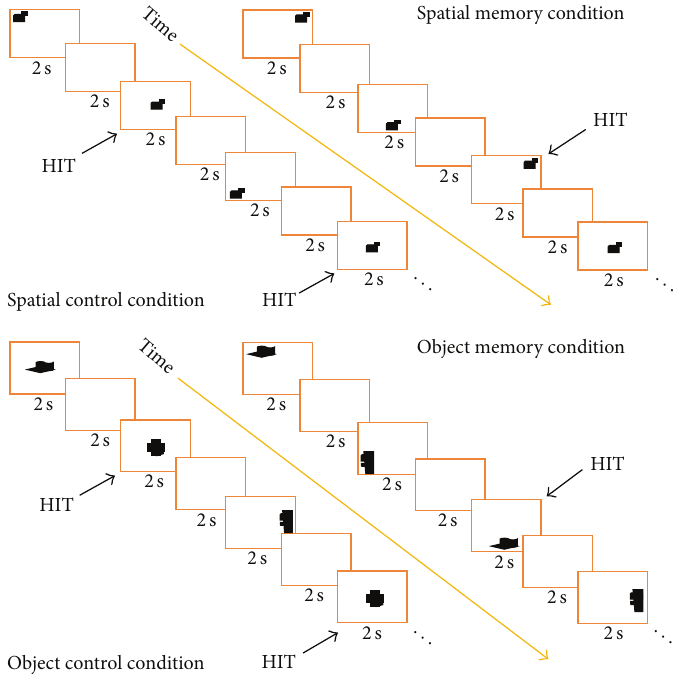
Figure 1: In the task condition, subjects had to press a key whenever they saw a repeated stimulus after 1 intervening stimulus. In the Spatial Memory Condition, they had to pay attention to the position of stimuli; in the Object Memory Condition, they had to focus on the shape of the stimuli.